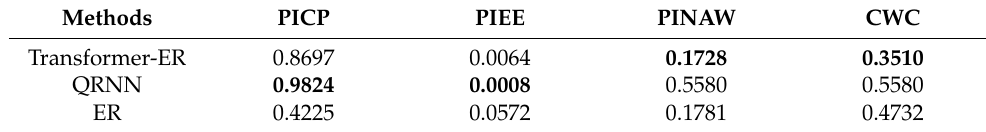
Table 4. Evaluation metrics for the interval prediction of various approaches.